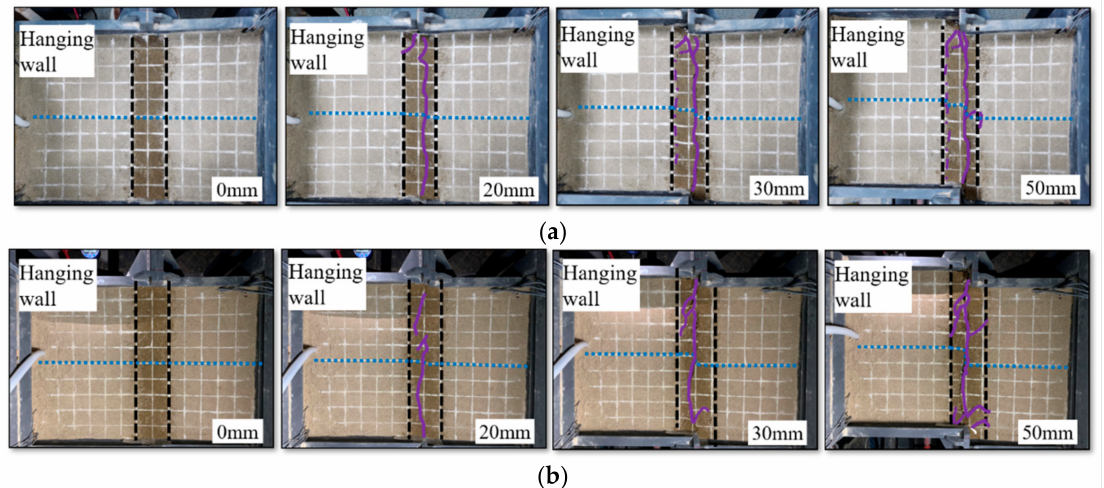
Figure 6. Deformation of rock mass for tunnel models. ( a ) lining without joints; ( b ) lining with joints.